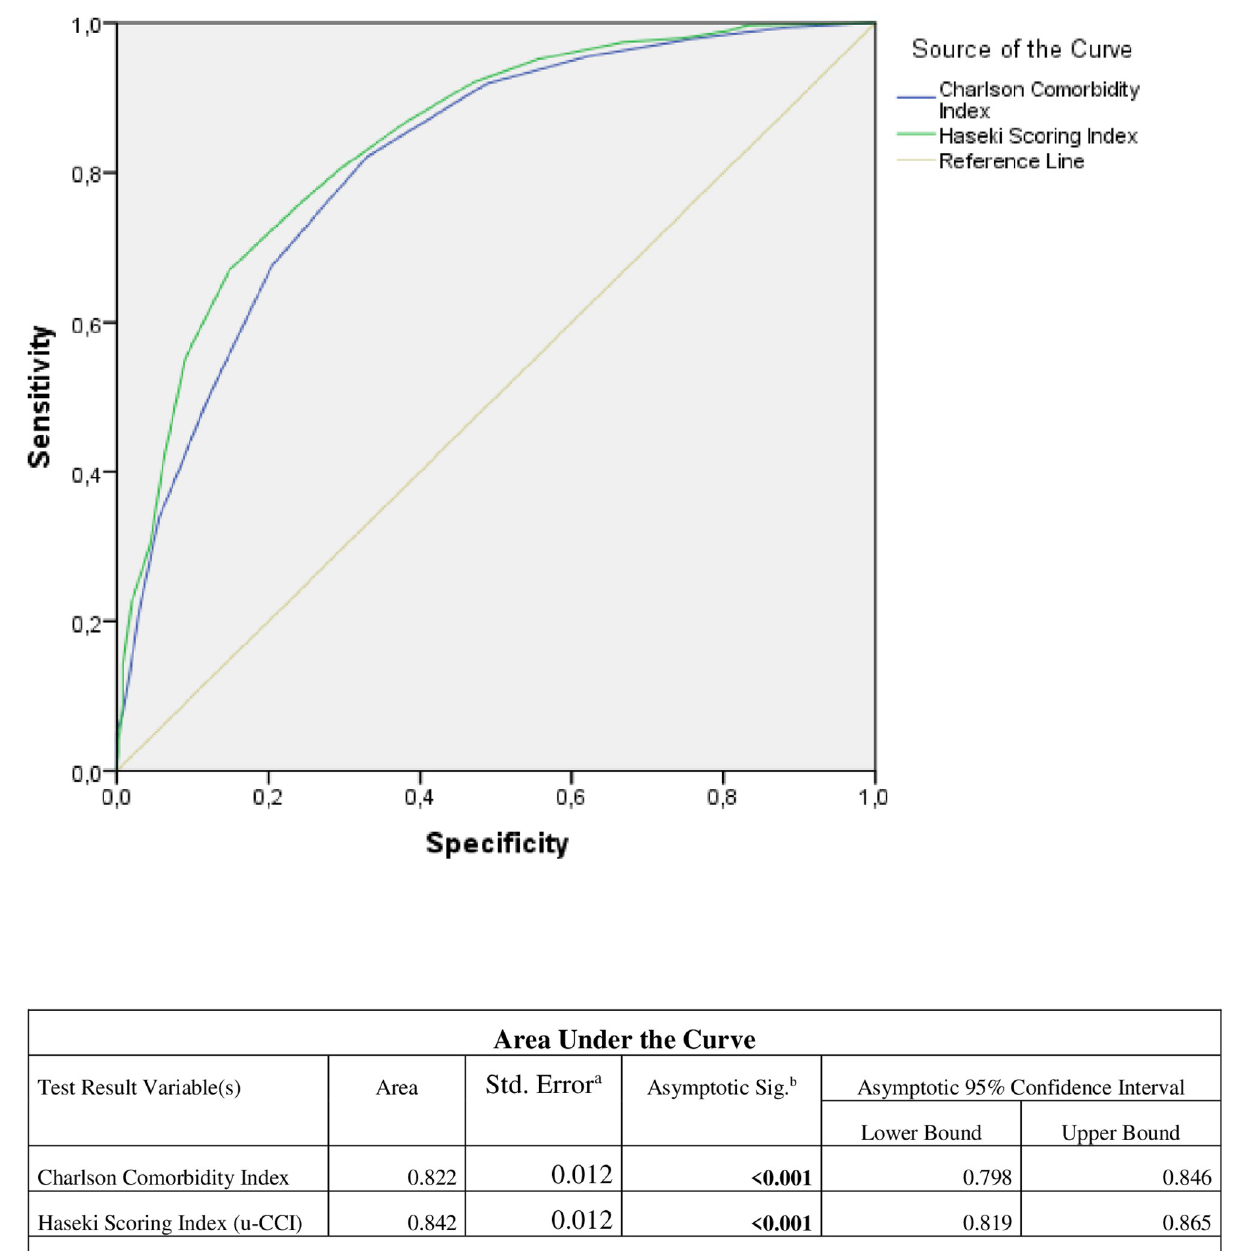
Fig 4. Roc analysis of Haseki Scoring Index (u-CCI) and Charlson Comorbidity Index in 5 year mortality.